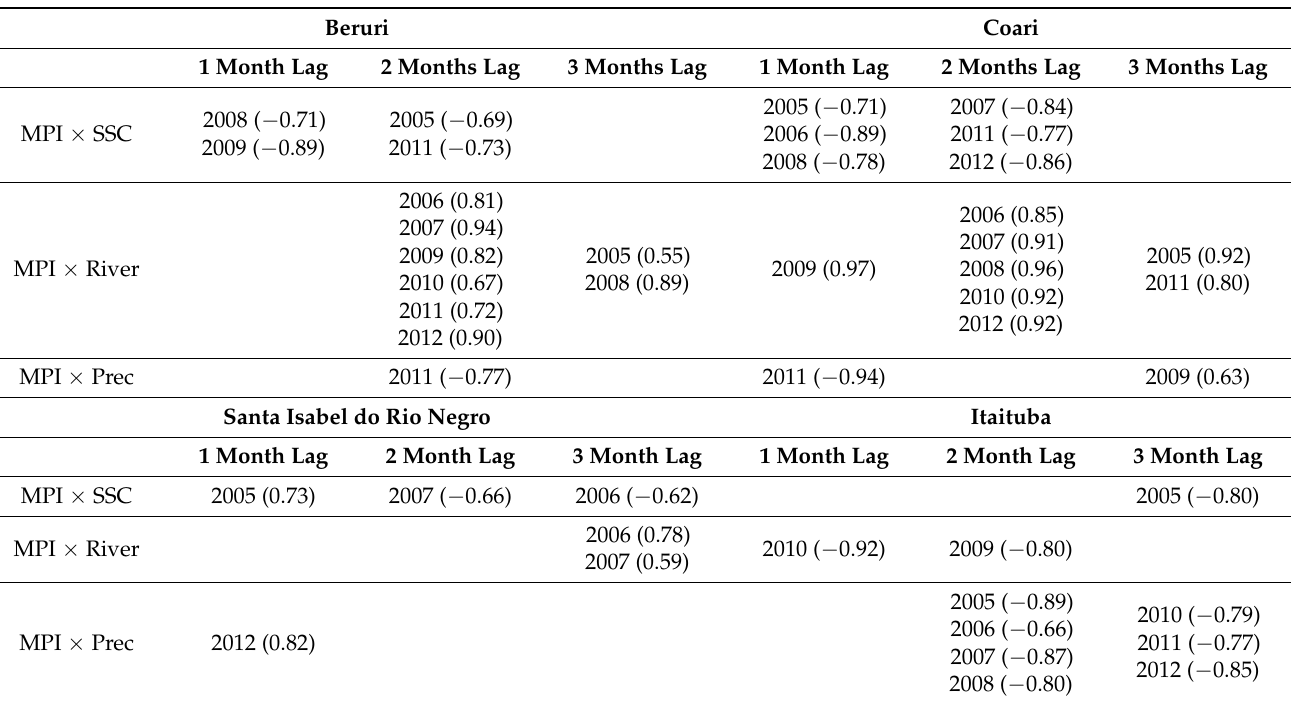
Table 2. Correlation of lag in monthly data on suspended sediment concentration in rivers (SSC), river level (River), and precipitation (Prec) with the monthly malaria parasite index (MPI). The table presents the years that had a significant increase in the lag ratio variables (up to 3 months) with MPI: Year